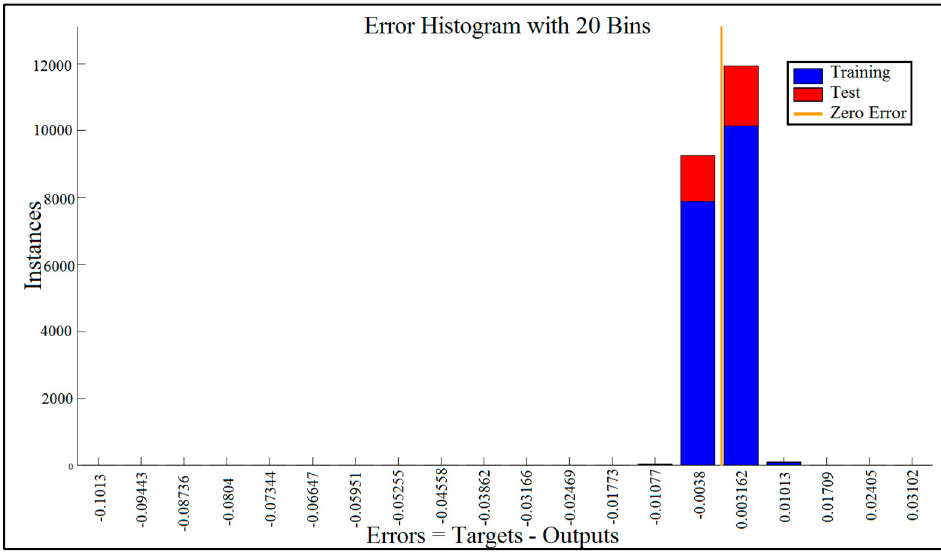
Figure 10. Error histogram visualized errors between target values and predicted values after training a feedforward neural network with 20 bins.